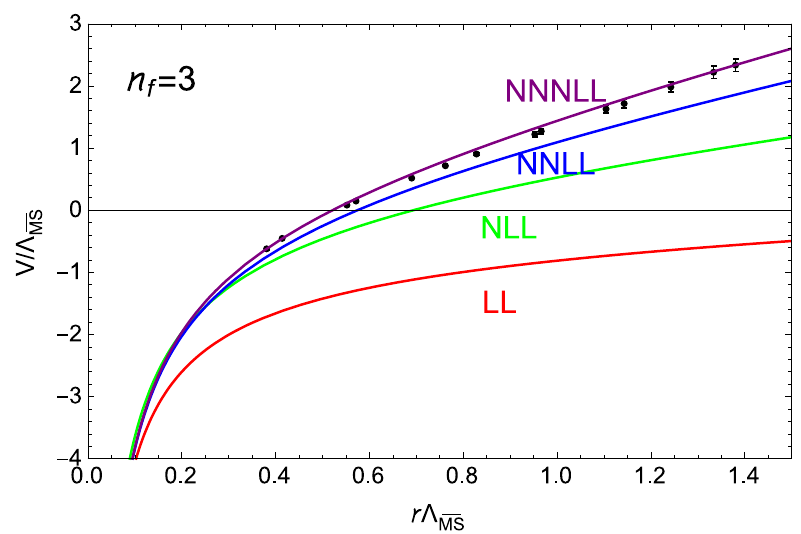
Figure 7 . Comparison of the lattice result X cont N 2 LL (blue), and N 3 LL (purple), for the inputs n f = 3 and (cid:11) s ( Q 2 ) = 0 : 2. (cid:3) PDG